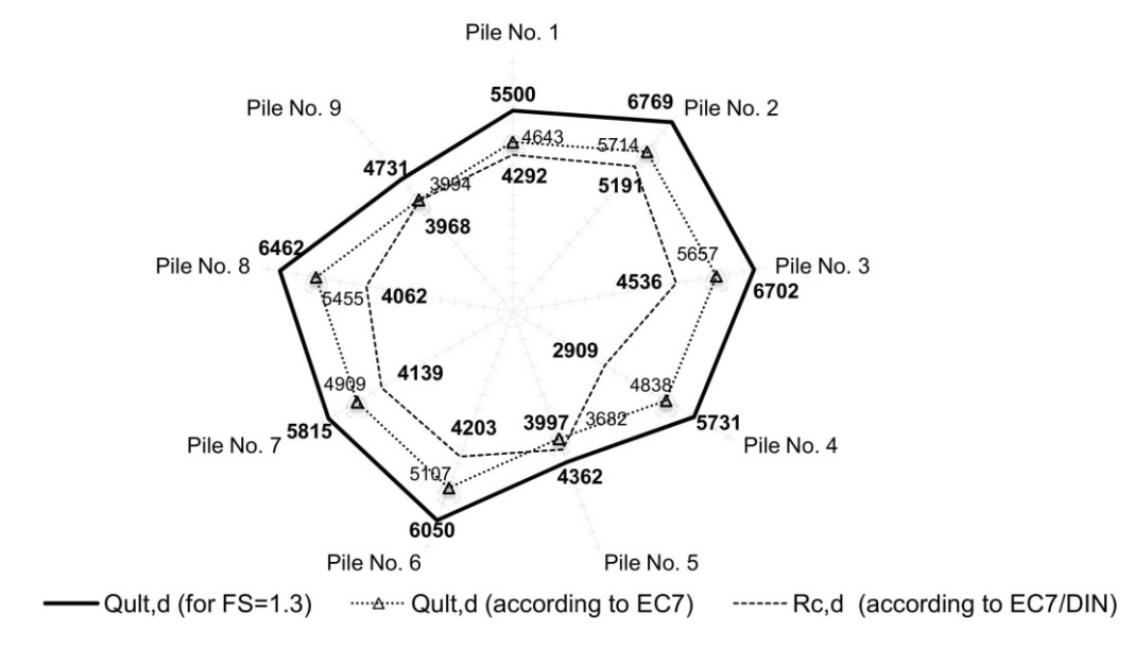
Figure 14: Comparison of design load-bearing capacity from diverse design methods.